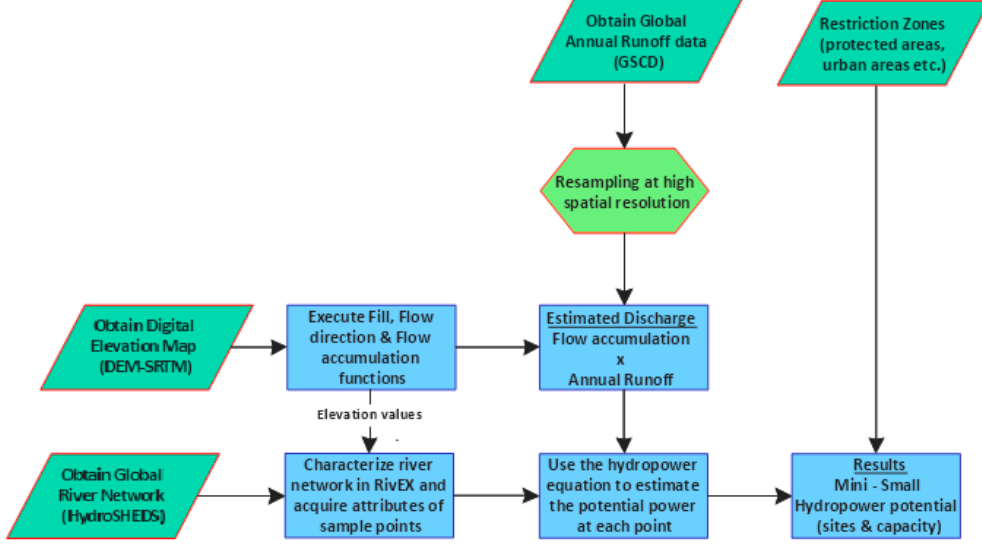
Figure 2. Small-scale hydropower assessment methodology flowchart.